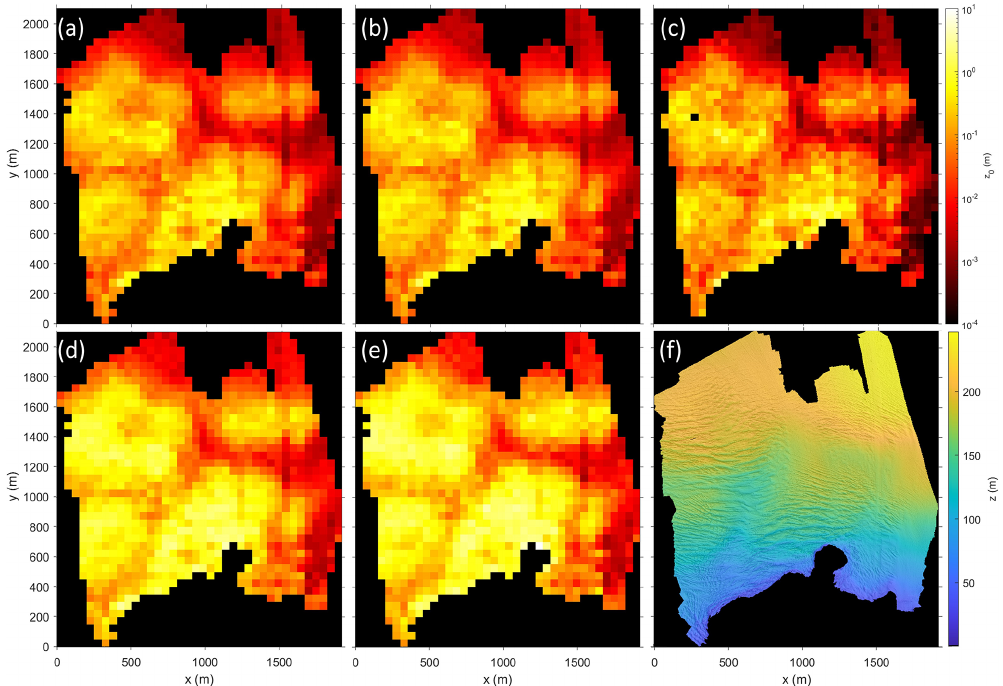
Figure 4. Variability in z 0 values for Nordenskiöldbreen (2019) depending on the calculation models – Smith (a) , Chambers (b) , Fitz- patrick (c) , Munro (d) and Lettau (e) – for a sub-grid size of 50m × 50m and a down-glacier wind direction. Graph (f) shows the DEM with the underlaid hillshade